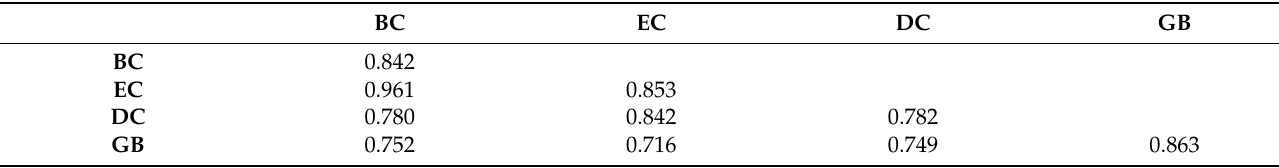
Table 7. The result of discriminative validity testing.